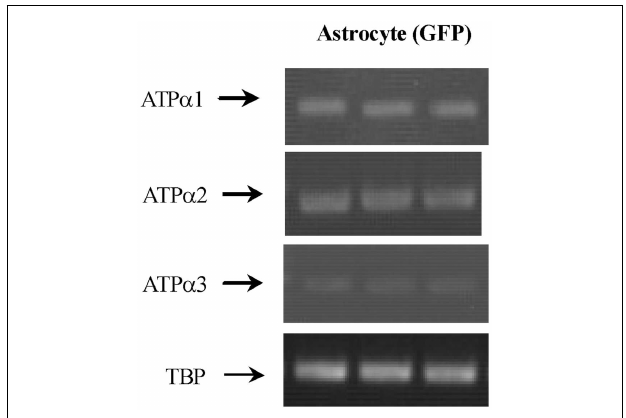
FIGURE 3 | mRNA expression measured by RT-PCR of α 1, α 2, and α 3 isoform of Na,K-ATPase in astrocytes isolated by FACS from cerebral hemispheres in vivo from adult mice [FVB/NTg(GFAP-GFP)14Mes/J] . A representative experiment showing mRNAs for α 1, α 2, and α 3 isoform and forTBP, as a house-keeping gene.The sizes of the PCR products of α 1 is 920bp, α 2 350bp, α 3 329bp, andTBP 236bp, n = 3. From